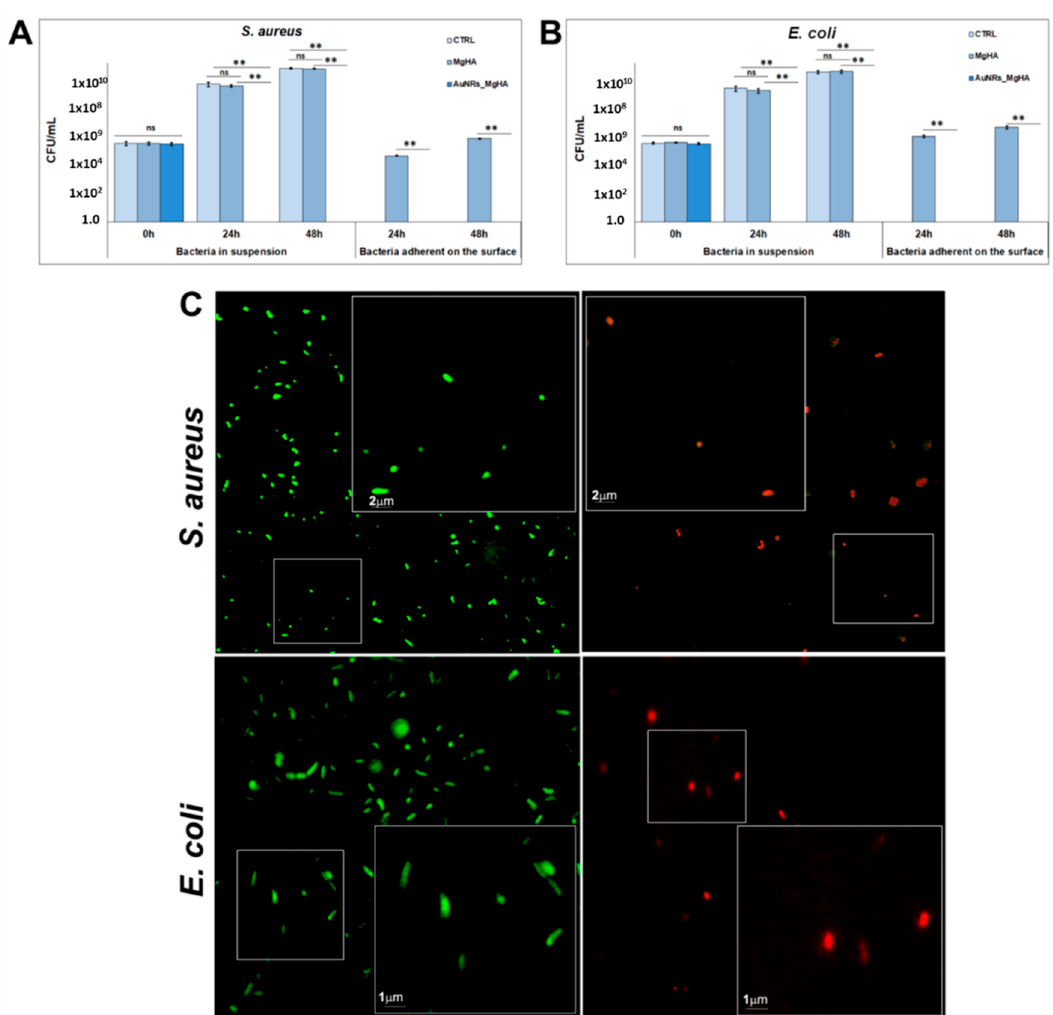
Figure 2. ( A , B ) Number of colonies (CFU) in MgHA and AuNR_MgHA scaffolds after 24 and 48 h of incubation for S. aureus and E. coli , respectively. The mean and standard deviation were obtained from three replicates. ANOVA test p values were reported ( p < 0.0001) and (** p < 0.01) indicating significant differences between scaffolds as reported by the Tukey post-hoc test; ns = not significant. ( C ) Live/dead staining of S. aureus and E. coli , on MgHA and AuNR_MgHA scaffolds. The inserts are magnifications of traced areas.